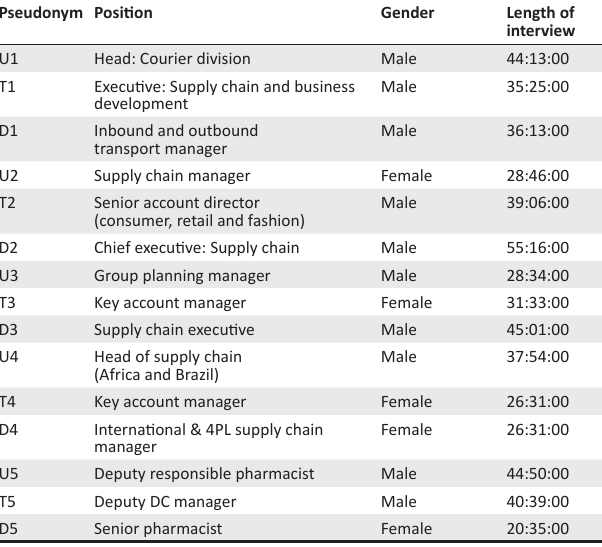
TABLE 1: Details of participants